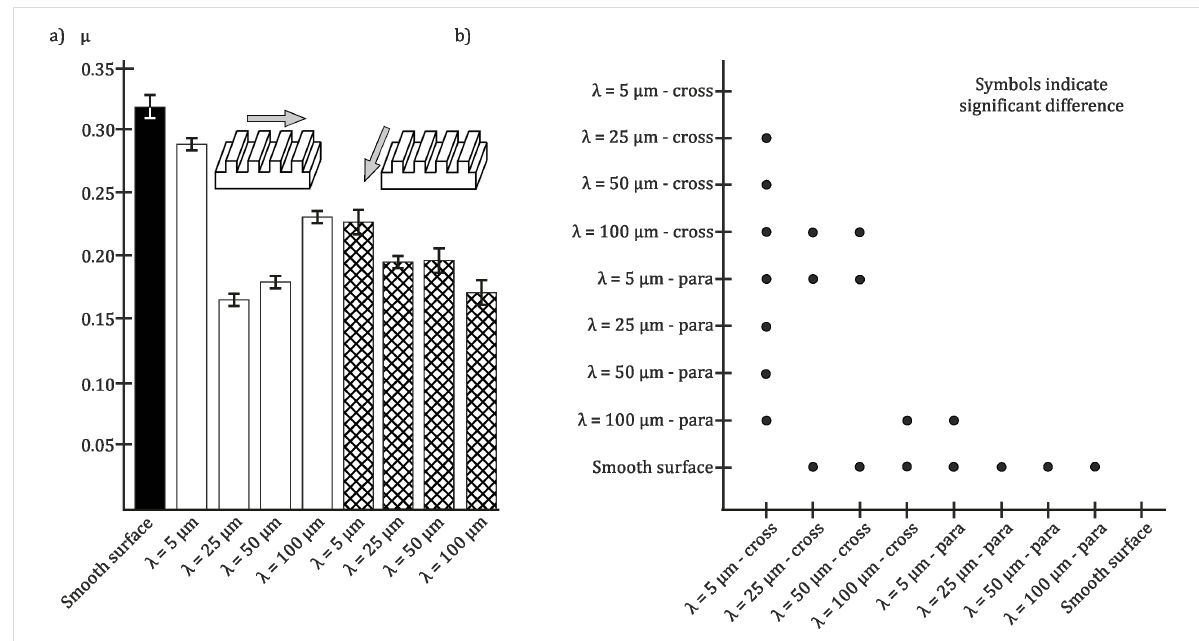
Figure 7: a) Results of tribological measurements of PGMS with different wavelengths ( λ ) in contact with a glass ball. The dimensions (structural wavelengths) of microstructures are 5 µm, 25 µm, 50 µm, and 100 µm, respectively. To investigate the influence of the geometry of the microstruc- ture on frictional properties, measurements were performed in two perpendicular sliding directions. Black column: smooth surface as reference. White columns: sliding direction perpendicular to the groove pattern. Patterned columns: sliding direction parallel to the grooves. Average frictional coeffi- cients (µ) and standard deviations are shown. b) Multiple comparison graph of the results presented in a). Dots indicate statistically significant differ- ences between samples.